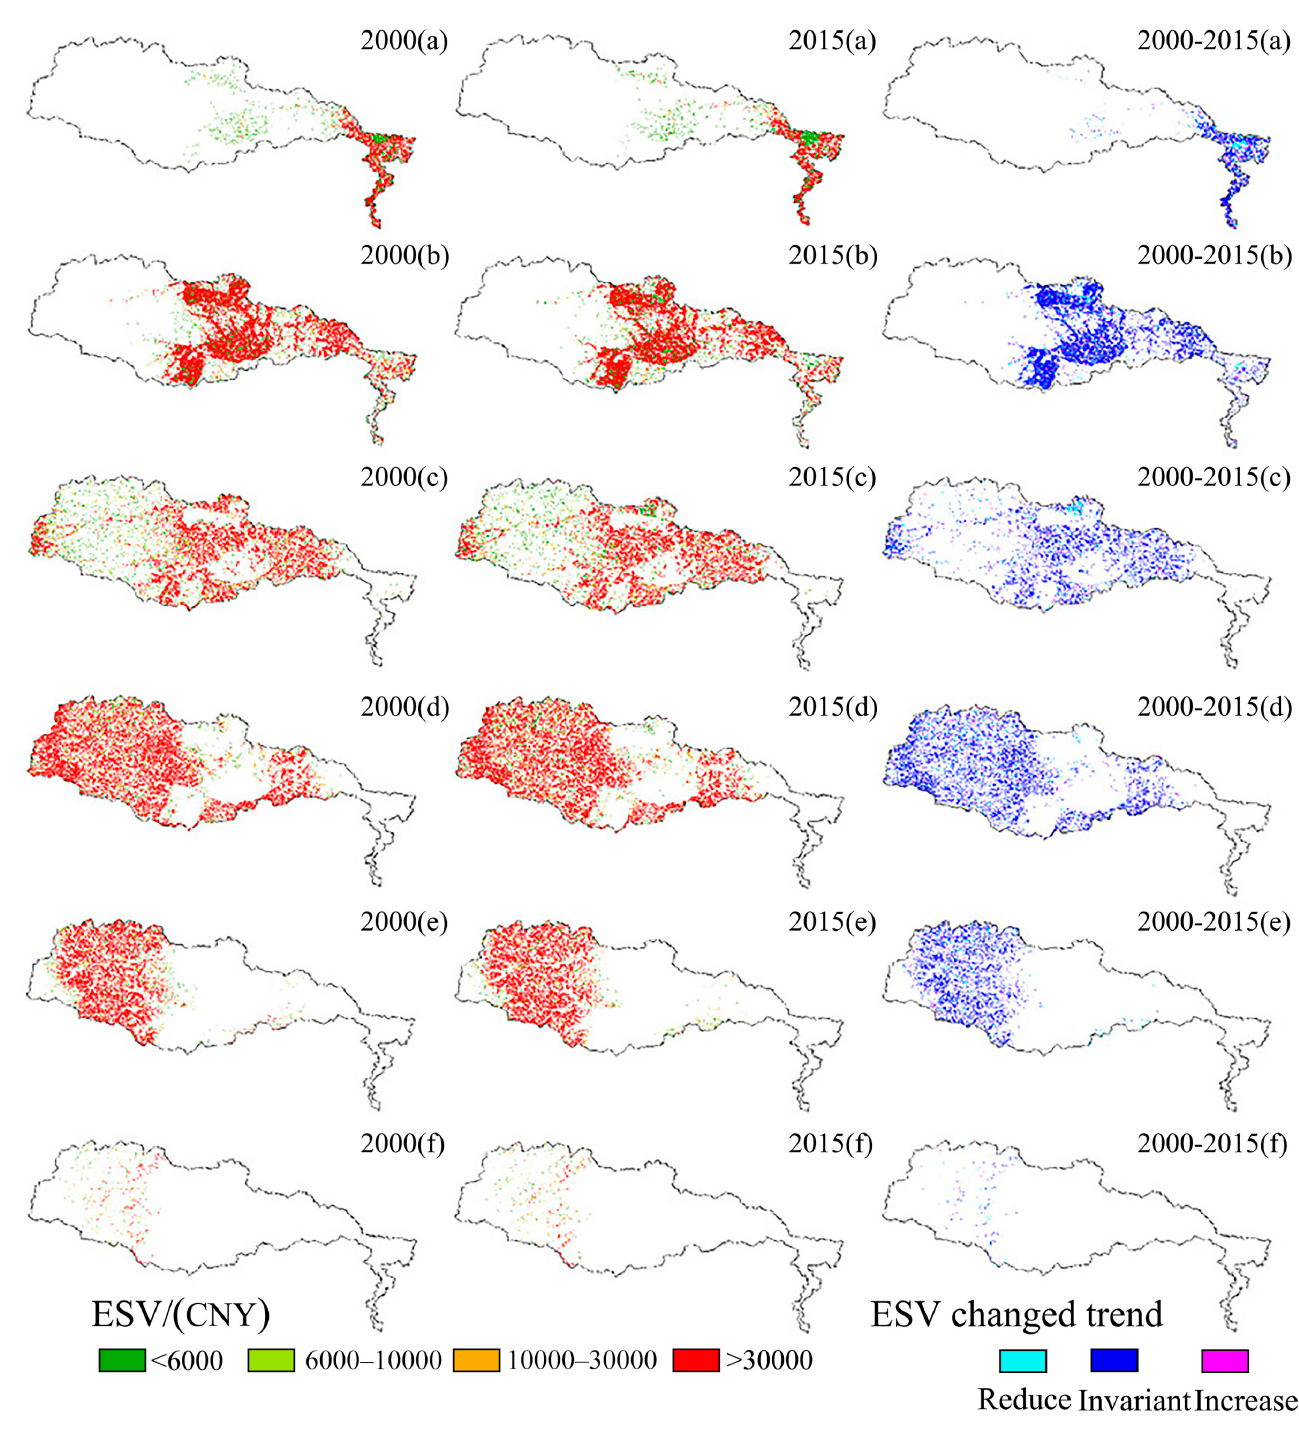
Figure 7. Characteristics of change in ecosystem service values of different topographic position indices (Note: a, b, c, d, e and f indicate 0–0.2, 0.2–0.4, 0.4–0.6, 0.6–0.8, 0.8–1, TPI > 1) in the Qihe watershed from 2000–2015.